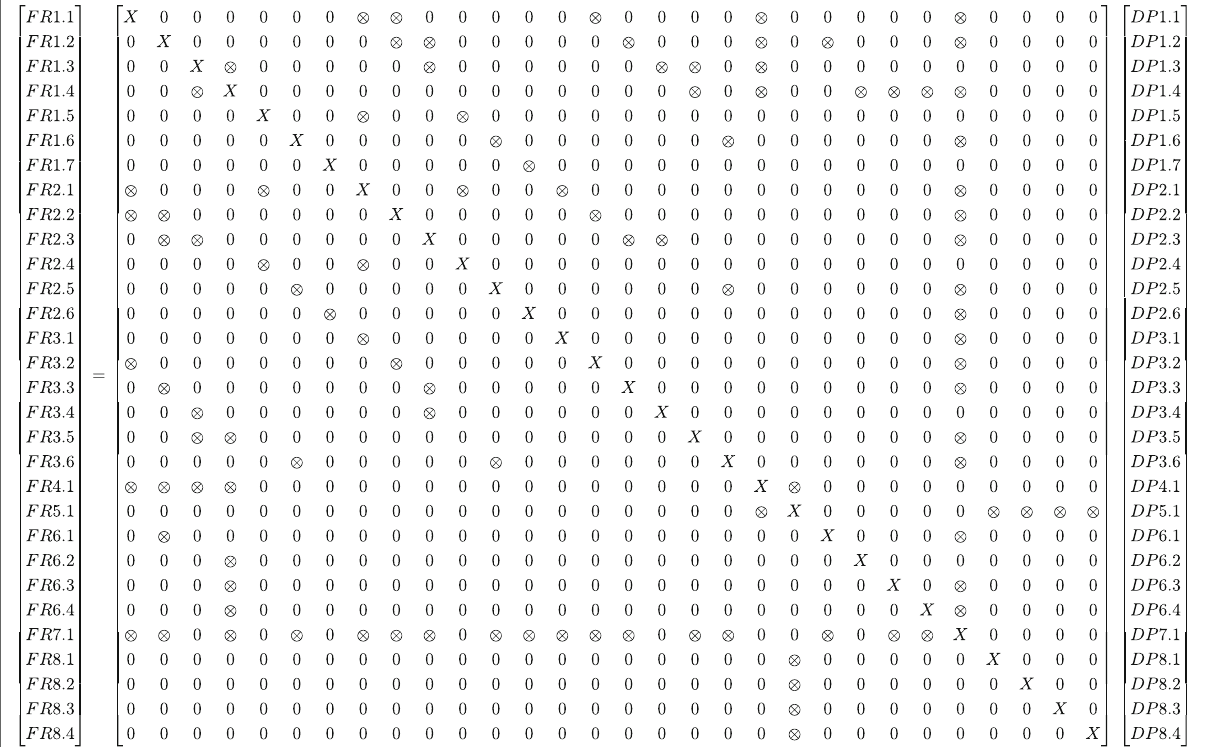
Fig. 4 Equation characterising the second-level information-state couplings